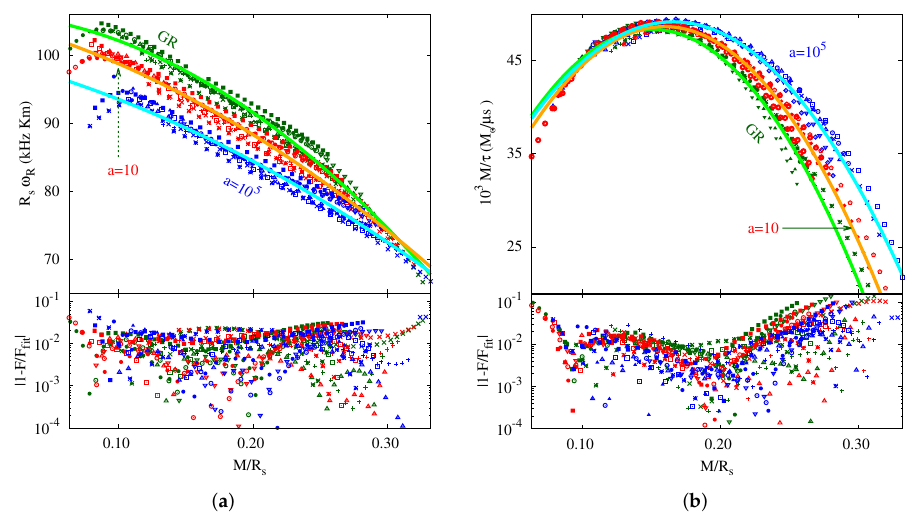
Figure 4. Universal relations for axial l = 2 QNMs of neutron stars in R 2 gravity: ( a ) scaled frequency ω R R vs. compactness M / R for a = 10 (red) and a = 10 5 (blue); ( b ) scaled damping time M / τ vs. M / R . Additionally shown are the deviations from the respective best fits, as well as the GR modes (green) for comparison [57].